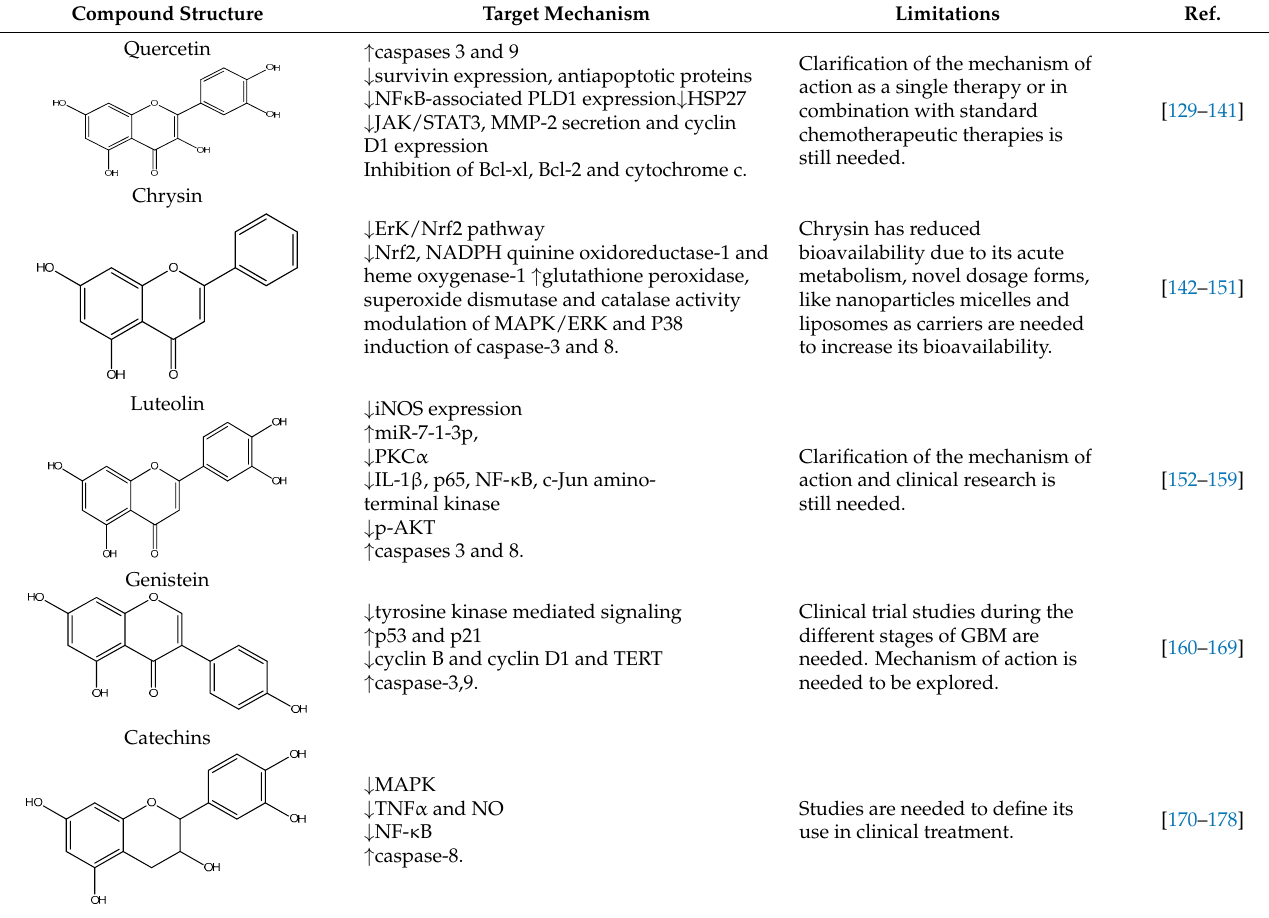
Table 1. Overview of phytoconstituents including structure, target mechanism and limitations. Compound Structure